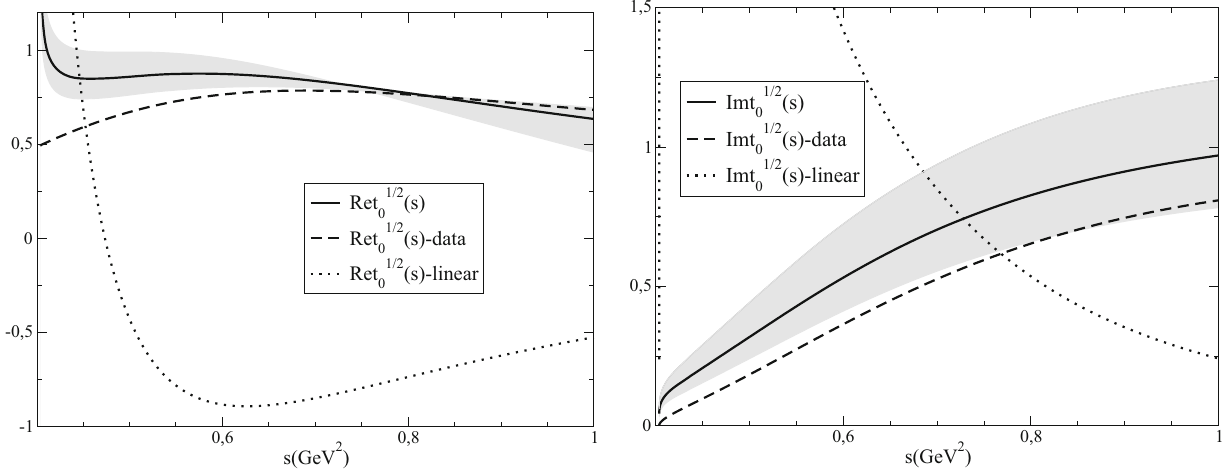
/ 2 ( s ) . Dashed shown as gray bands . The dotted lines , which are completely at odds 0 with the data curve, represent the single Regge-pole partial wave when imposing an ordinary linear Regge trajectory with α (cid:3) (cid:8) 0 . 9 GeV − 2 , as a solution from the dispersive equations of α( s ) and β( s )